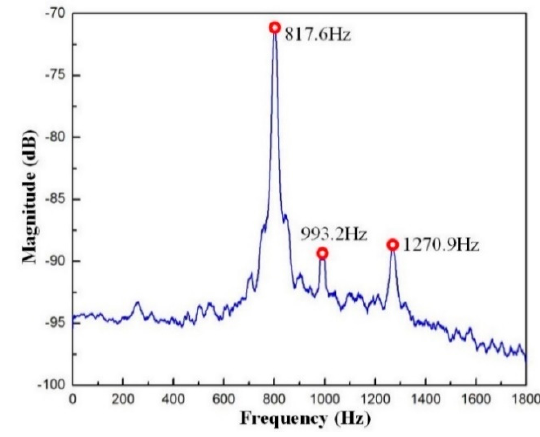
Figure 11. Dynamic responses of the VPD at point B.